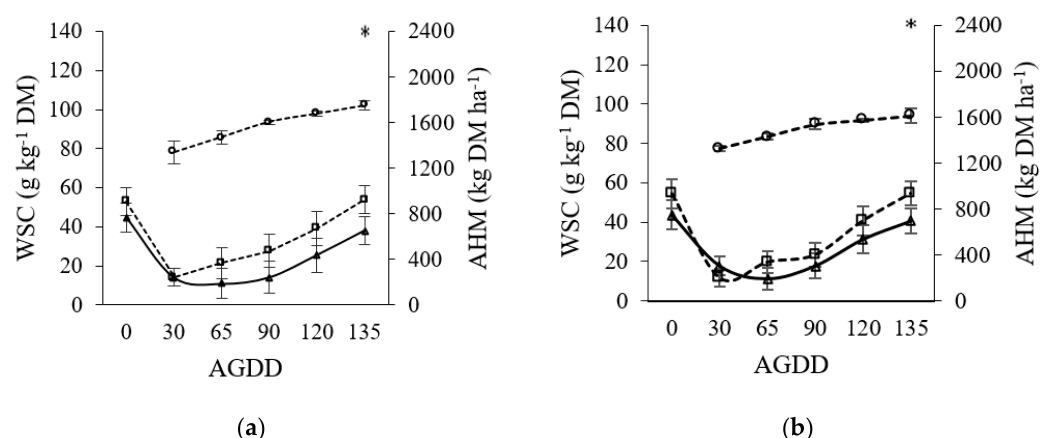
Figure 4. Mean of two growth cycle for water soluble carbohydrates (WSCs, g kg − 1 DM) and accumulated herbage mass (AHM, kg DM ha − 1 ) in Bromus valdivianus Phil. ( a ) and Lolium perenne L. ( b ) in: leaf blades (- △ -) and leaf sheath (-- □ --) defoliated at 135 accumulated growing degree days (AGDDs) and AHM (--o--). * Indicates significant differences ( p < 0.05) between leaf sheaths and blades for the same species. Bars indicate the standard error.